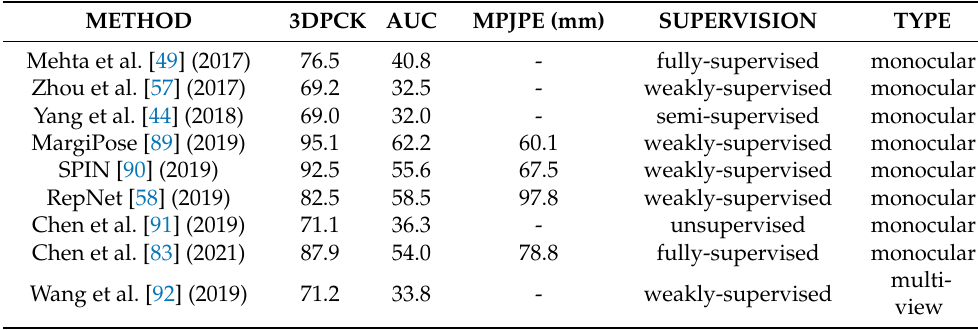
Table 3. Summary of the state-of-the-arts methods on MPI-INF-3DHP datasets. ‘-’ means no pub- lished